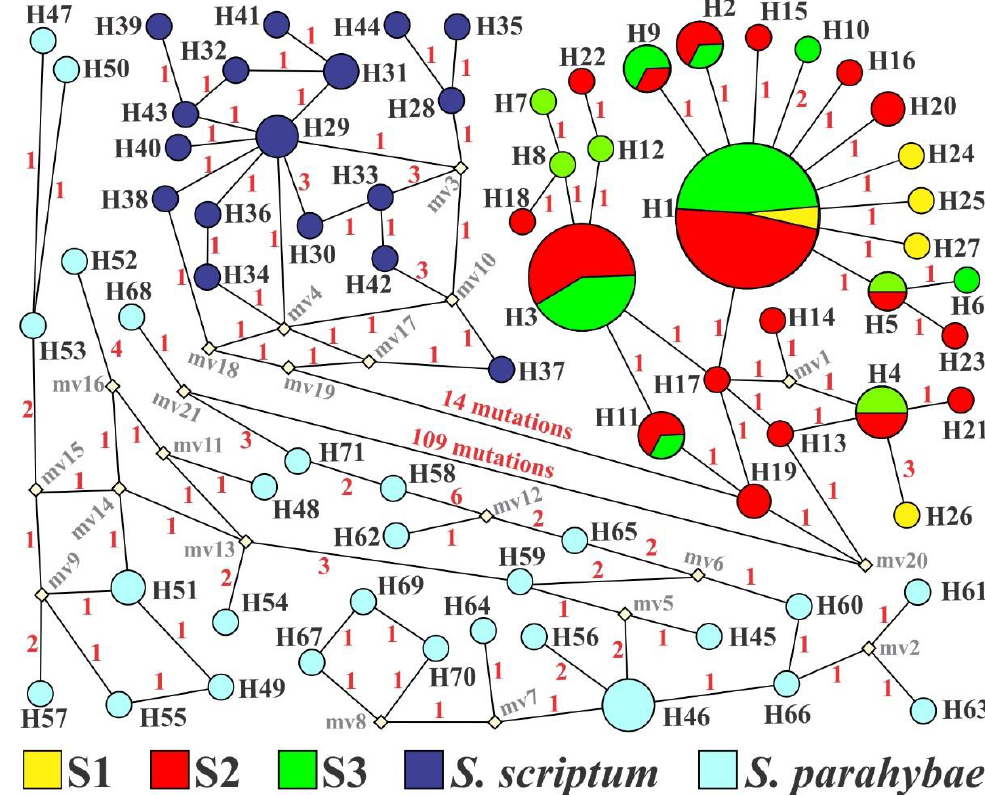
Figure 3. Median-joining network among 27 haplotypes of 95 individuals of Steindachneridion melanodermatum samples, 27 haplotypes of S. parahybae , and 17 haplotypes of S. scriptum , based on partial sequencing of the D-loop region (mtDNA). The colors indicate locality; circle sizes are proportional to haplotype frequency, and small black circles are hypothetical ancestors or unsampled haplotypes. Numbers between haplotypes denote mutational steps between sequences.